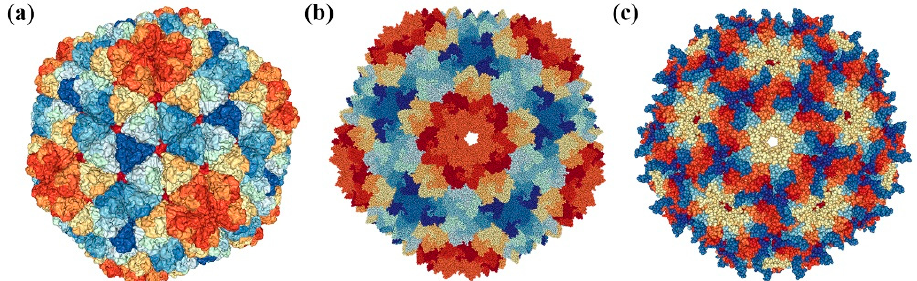
Figure 7. Projections of bioparticles used for SPI experiments. ( a ) Biological assembly of double- shelled rice dwarf virus (RDV). RDV is a member of the genus Phytoreovirus in the family Reoviridae. The atomic structure was determined by X-ray crystallography at 3.5 Å resolution [166]; ( b ) Quasi- atomic structure resolution model of bacteriophage PRD1 wild type virion. PR772 belongs to the PRD1 family. The dsDNA bacteriophage has a membrane inside its icosahedral capsid. The